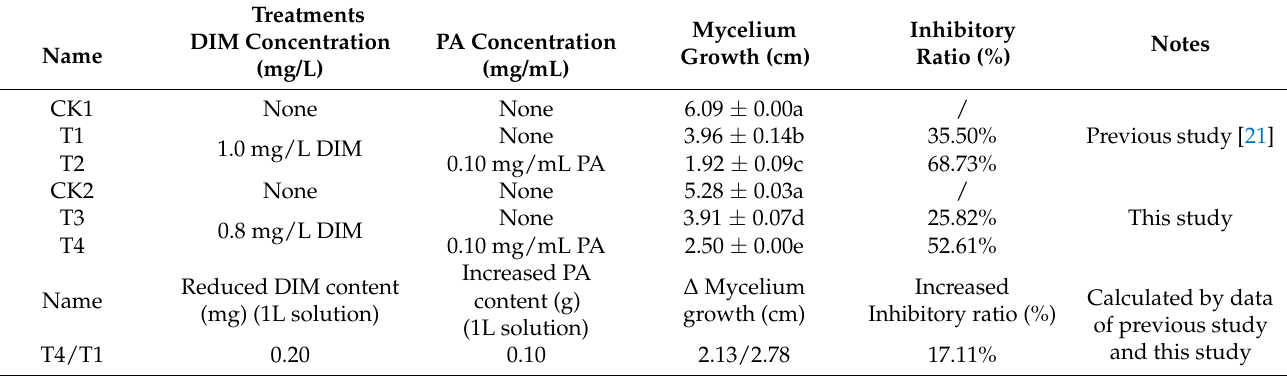
Table 3. Combined inhibition of different concentration of DIM and PA on S. sclerotiorum growth. Treatments